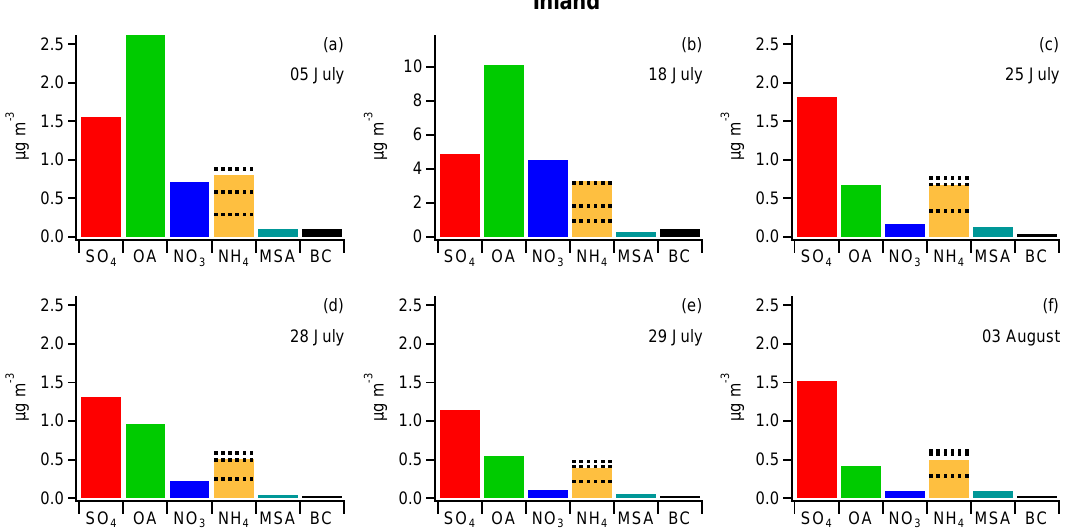
Figure 5. As in Fig. 4 but for measurements taken inland over the southwest peninsula of the UK.